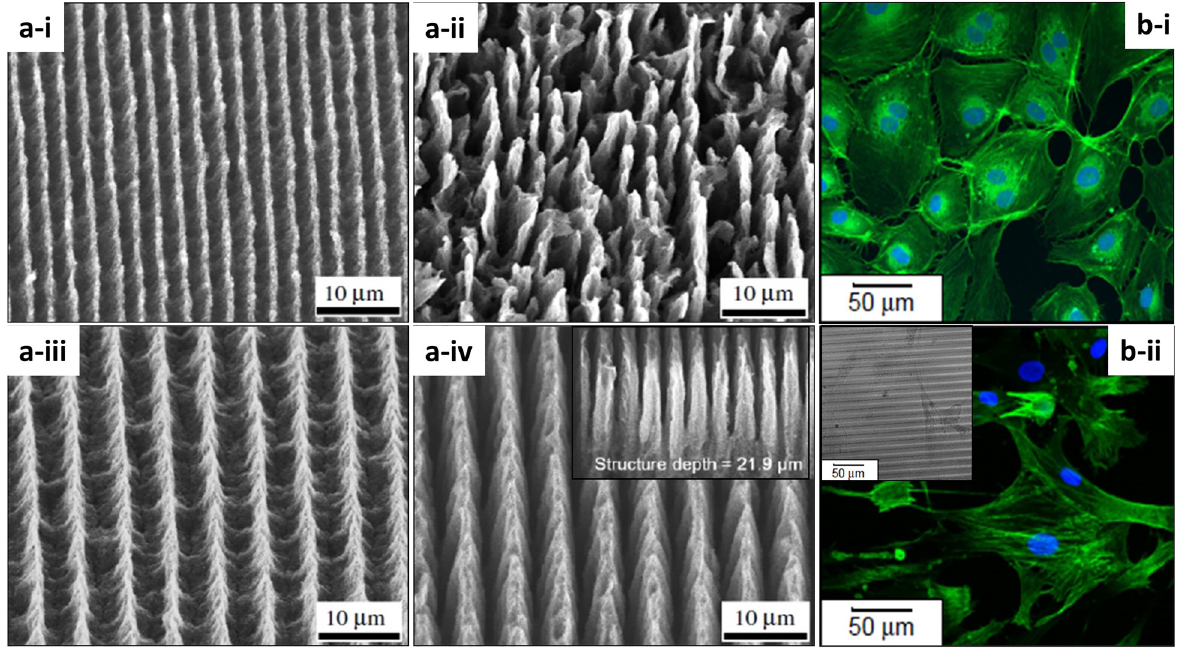
Figure 21: (a) SEM of one-dimensional vertical CNTs arrays produced (326 mJ cm − 2 ) by interference pattern irradiation with (a-i) 2.86 µm spatial period and 1 pulse, (a-ii) 2.86 µm, N = 15, (a-iii) 5.73 µm, N = 1 and, (a-iv) 5.73 µm, N = 20 where it is showing the cross section of the lineararrays.(b)Confocalmicroscopyimageswith fl uorescentlabelingofsmoothmusclecellsculturedonDLClayers:(b-i)non-patternedslice and (b-ii) patterned slides with lamellipodia (elongation) response and SEM image of linear migration channels (upper left). Figures (a) and (b) adapted from ref. [186, 187] (© 2009 IOP